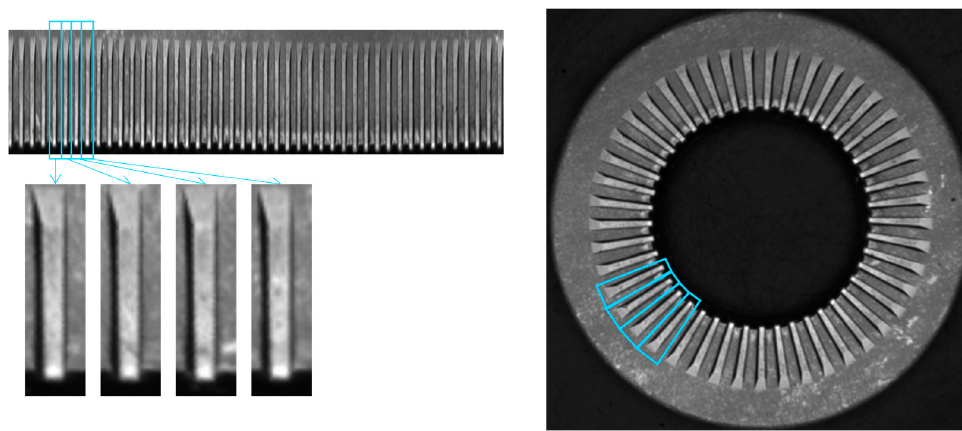
Figure 10. Teeth extraction from the stripe and visualization of the teeth on the original circularly symmetric image of the knurled washer.